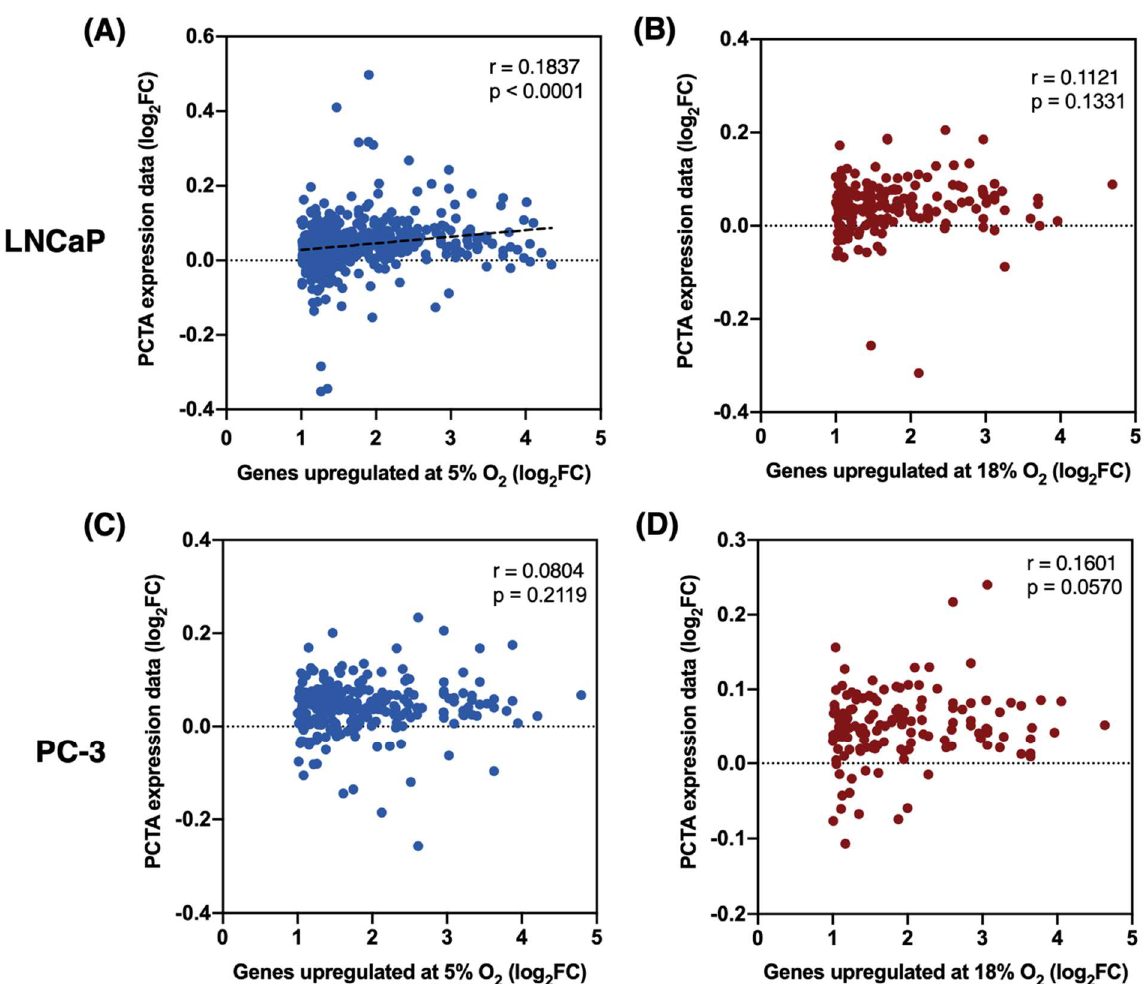
Figure 5. Correlation between gene expression levels (log 2 FC) between PCTA expression data and DEGs upregulated at ( A ) 5% O 2 and ( B ) 18% O 2 in LNCaP cells, and DEGs upregulated at ( C ) 5% O 2 and ( D ) 18% O 2 in PC-3 cells.